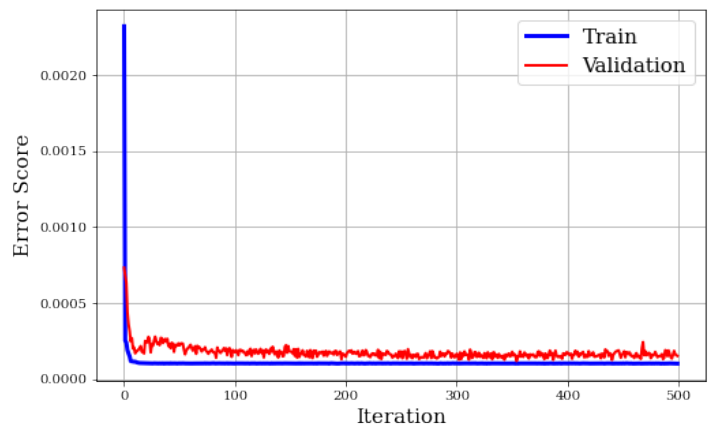
Figure 10. HI illustrating the TSP from the 5 σ technique.